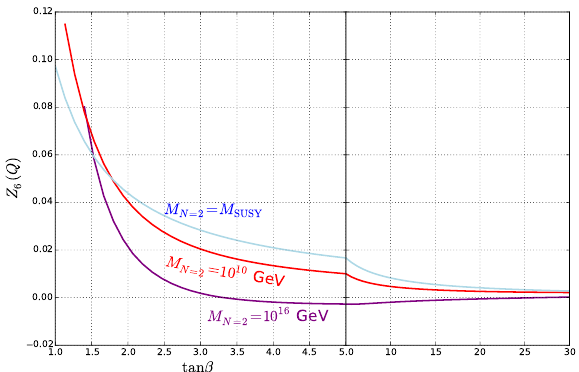
Figure 1. Z 6 ( Q ) at the low energy scale Q against tan β for the N = 2 scale M N = 2 = M SUSY ,10 10 GeV and 10 16 GeV